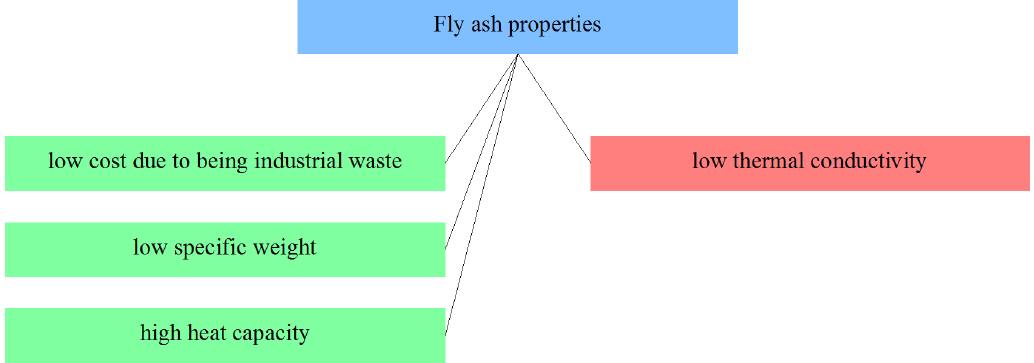
Figure 19: Selected fly ash composites properties from the point of view of applicability in friction materials